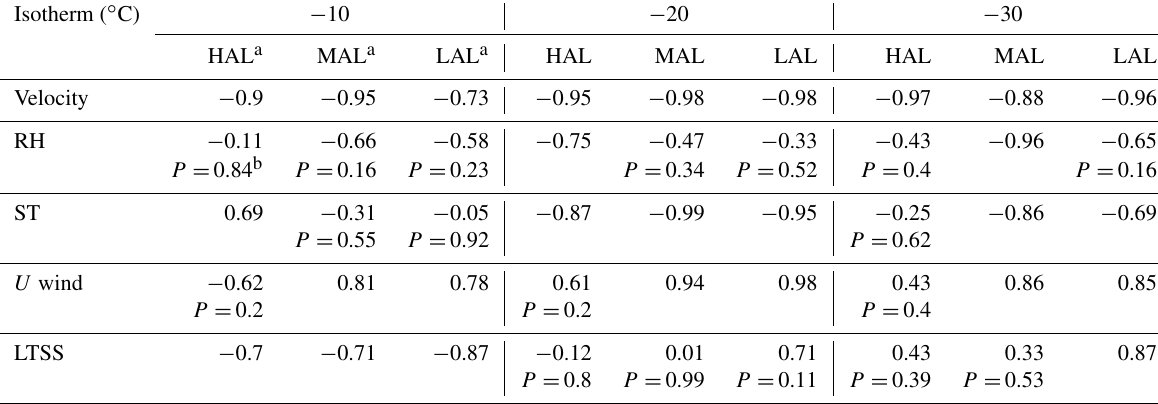
Table 1. The summary of spatial correlation coefficients between SCFs and meteorological parameters at three isotherms under different aerosol loading conditions. Only regions with temporal correlations between SCFs and meteorological parameters at the 90% confidence level are used to calculate the spatial correlations between SCFs and meteorological parameters. Isotherm ( ◦ C) − 10 − 20 − 30 HAL a MAL a LAL a HAL MAL LAL HAL MAL LAL Velocity − 0.9 − 0.95 − 0.73 − 0.95 − 0.98 − 0.98 − 0.97 − 0.88 − 0.96 RH − 0.11 − 0.66 − 0.58 − 0.75 − 0.47 − 0.33 − 0.43 − 0.96 − 0.65 P = 0.84 b P = 0.16 P = 0.23 P = 0.34 P = 0.52 P = 0.4 P = 0.16 ST 0.69 − 0.31 − 0.05 − 0.87 − 0.99 − 0.95 − 0.25 − 0.86 P = 0.55 P = 0.92 P = 0.62 U wind − 0.62 0.81 0.78 P = 0.2 P = 0.2 LTSS − 0.7 − 0.71 − 0.87 − 0.12 0.01 P = 0.8 P = 0.99 P =